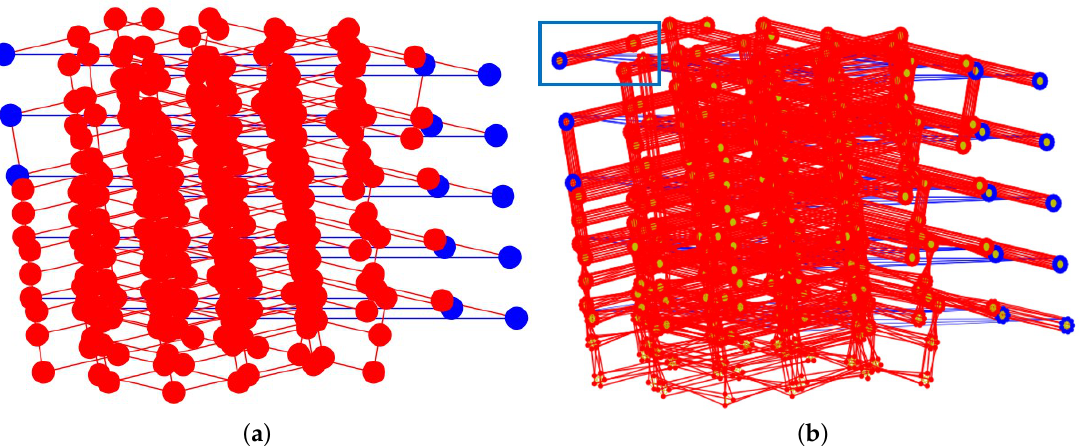
Figure 10. The graphs generated at the task level. The object poses are first sampled and shown in the left graph, then the right graph is built by combining grasp configurations. ( a ) Graph of the sampled object poses. The red nodes indicate the object poses in SP, whereas the blue nodes indicate USP. The red and blue edges indicate pivoting and tumbling motion, respectively. ( b ) Grasps combined with the graph shown in ( a ). Each node includes information on both the object pose and grasp configuration. Yellow edges are added, which indicate the regrasping to change the grasp